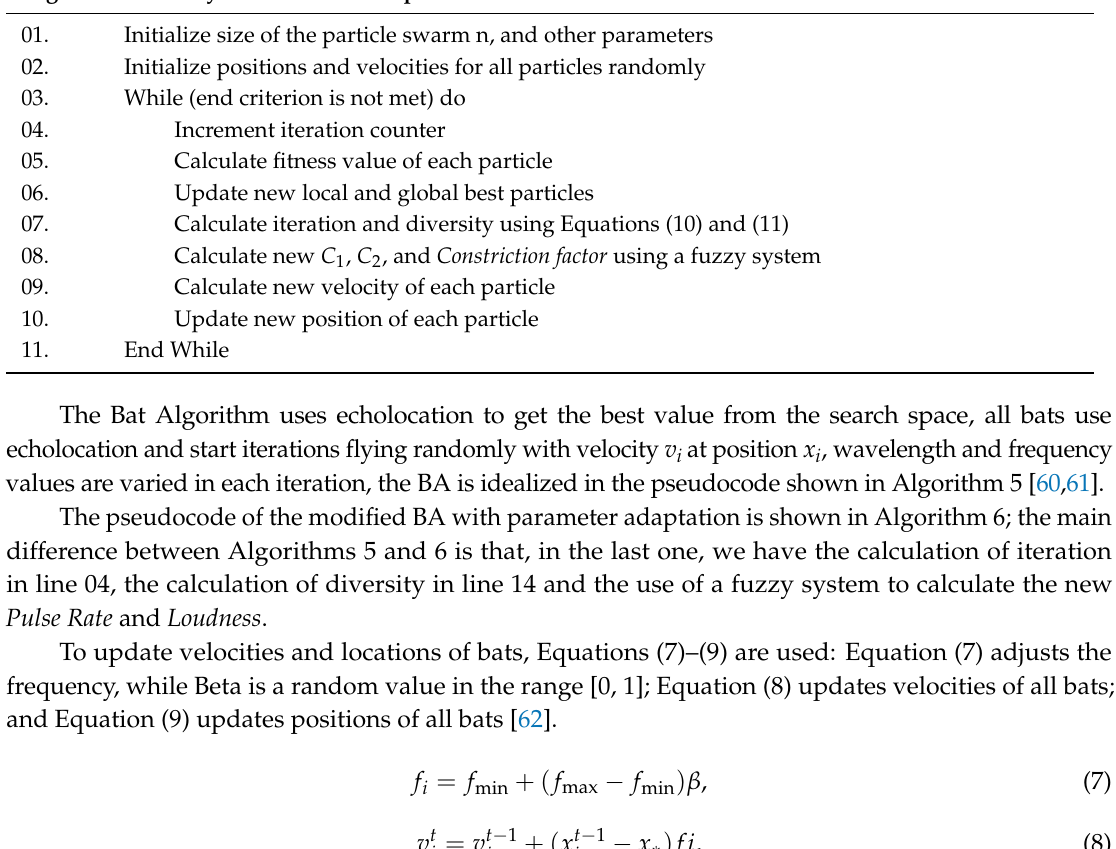
Algorithm 4. Fuzzy Particle Swarm